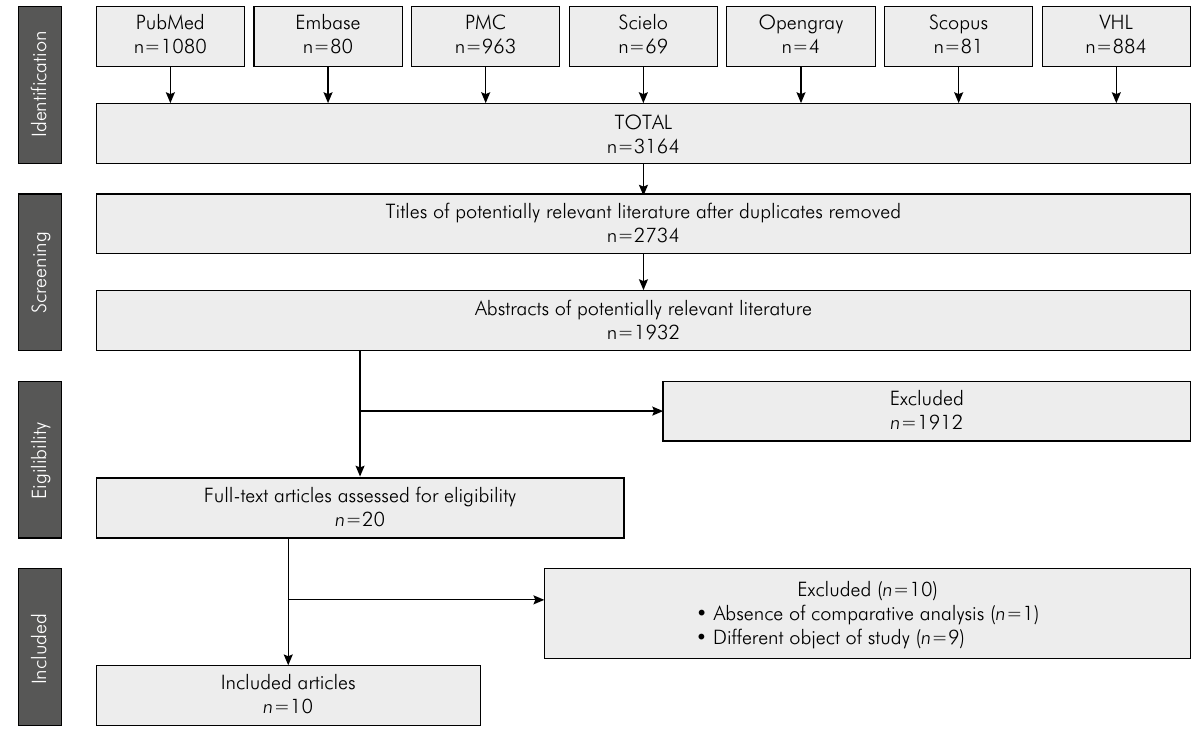
Figure 1. Flowchart of the methodology.